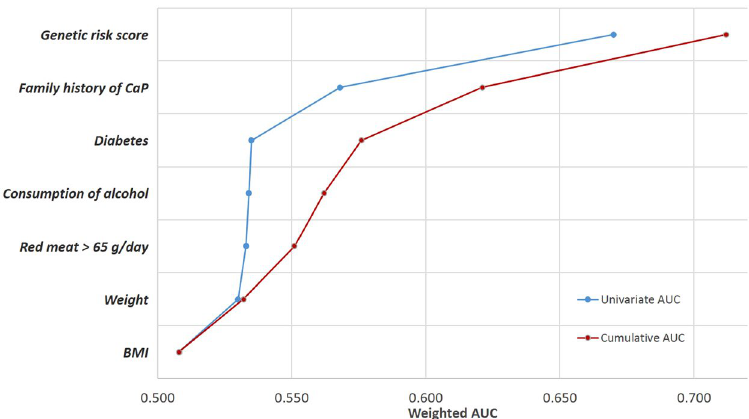
Figure 2. Individual and cumulative contribution of each factor to prostate cancer predictive accuracy. The area under the ROC curve (AUROC), as indicator of predictive accuracy for each variable in the risk model is shown. The left discontinuous (blue) line indicates the individual contribution of each variable, and the right continuous (red) line indicates the cumulative contribution, bottom to top. Environmental variables are sorted by increasing